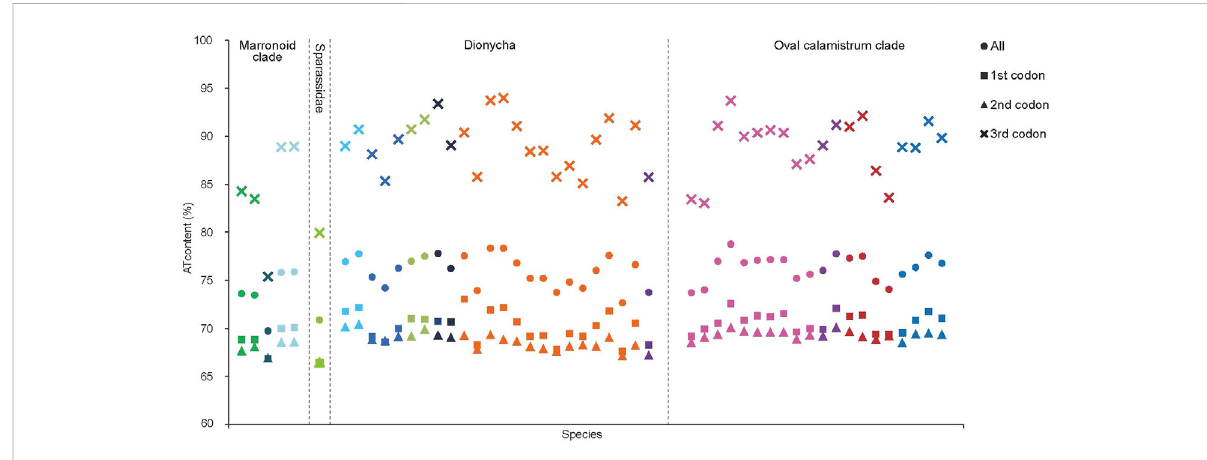
FIGURE 3 A + T% of the mitochondrial protein-coding genes among three groups within the retrolateral tibial apophysis clade. The colors of the symbols match those in Figure